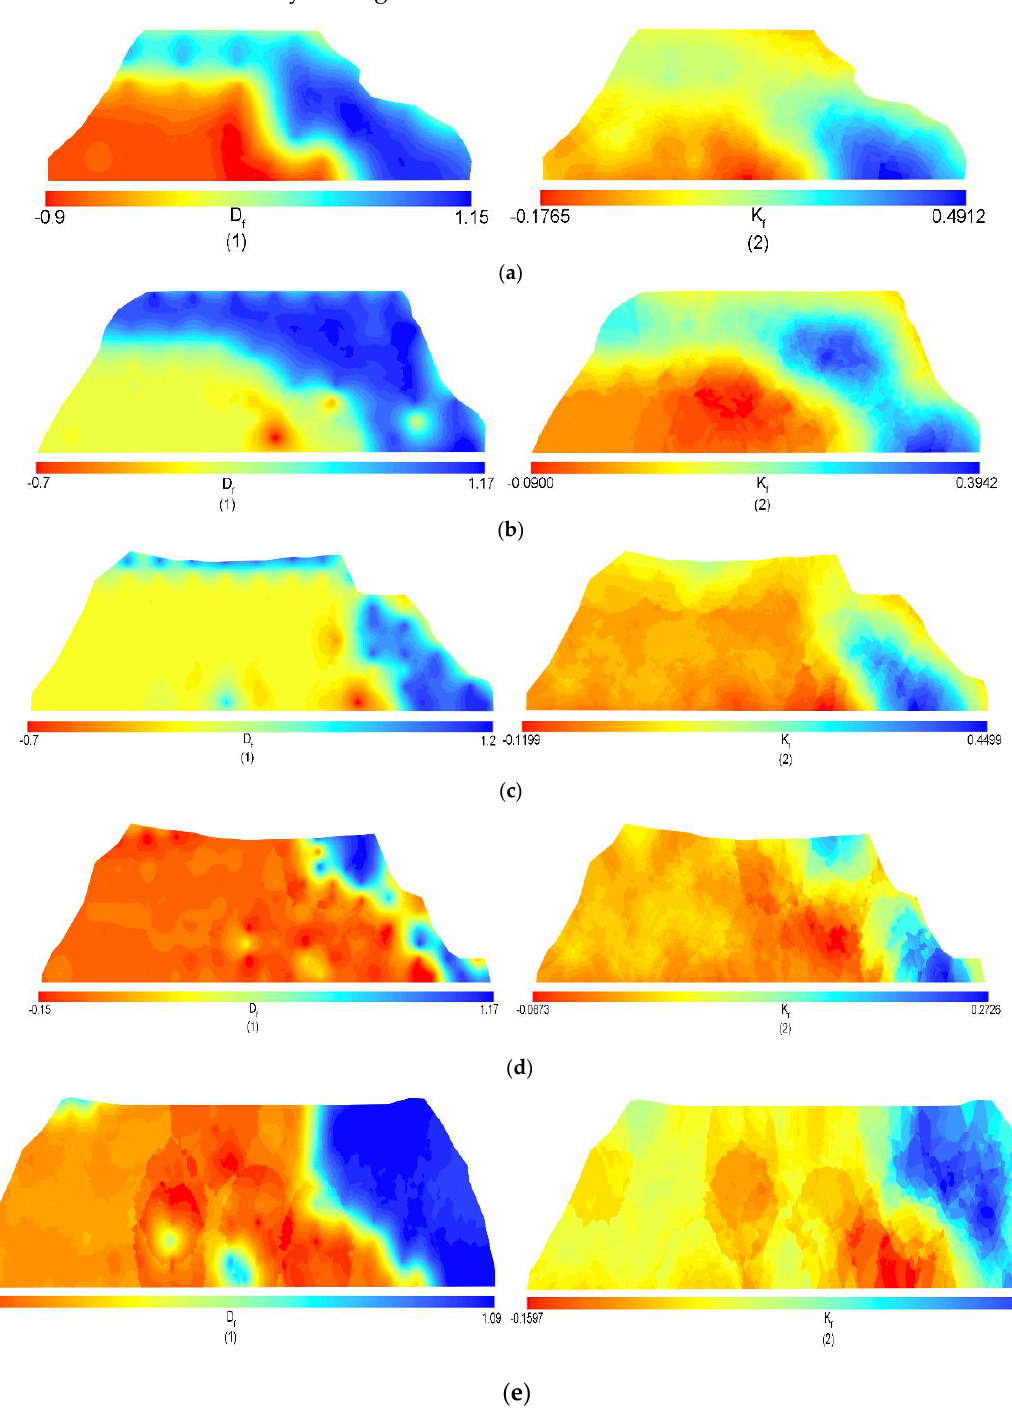
Figure 8. Incremental changes in spatiotemporal parameters of fractal dimension and fracture entropy of rock mass fractures: ( a ) 120 – 180 m; ( b ) 180 – 240 m; ( c ) 240 – 300 m; ( d ) 300 – 340 m; ( e ) 340 – 400 m; 1 fractal dimension, and 2 fracture entropy. Table 3. Criteria for determining the spatiotemporal state of rock mass fractures due to mining.